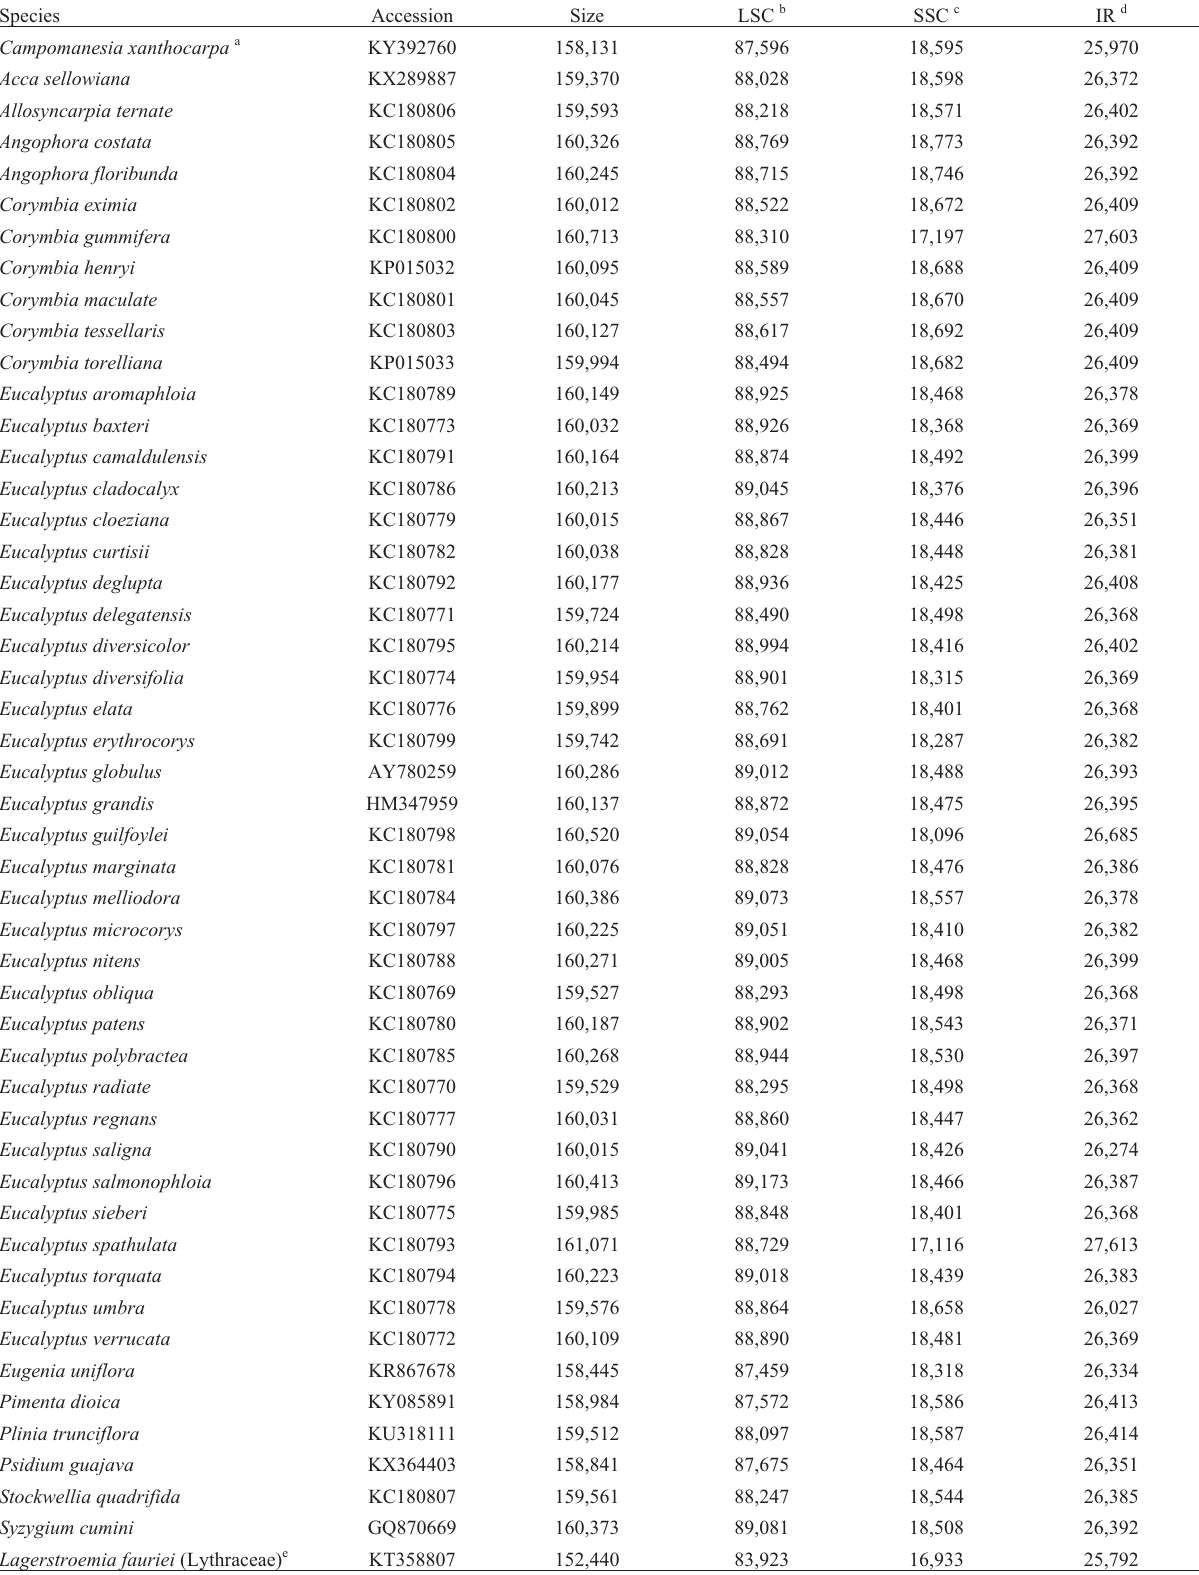
Table 1 - Comparison of chloroplast genomes of Myrtaceae species and outgroup analyzed in this study.